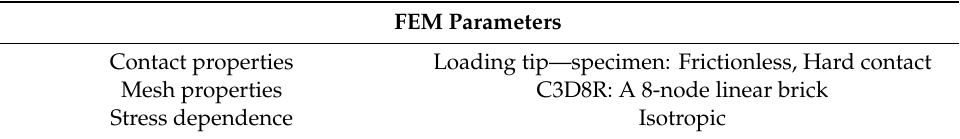
Table 5. Parameters used in FEM.